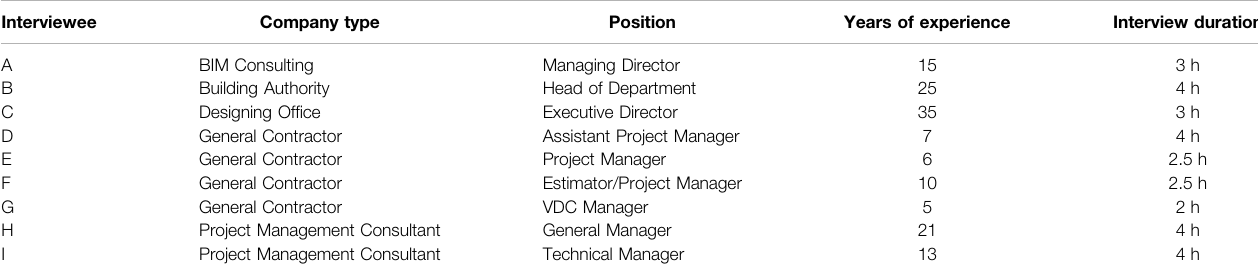
TABLE 1 | Pro fi le of